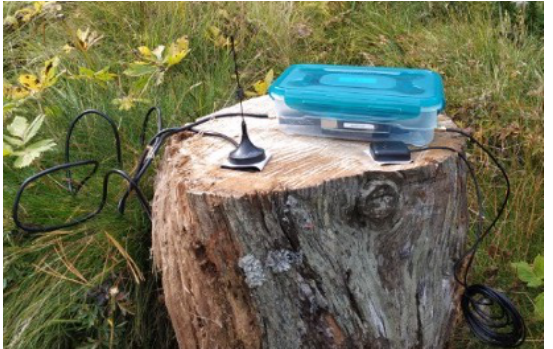
Figure 4. Side view of the system and its antennas in an outdoor setup.